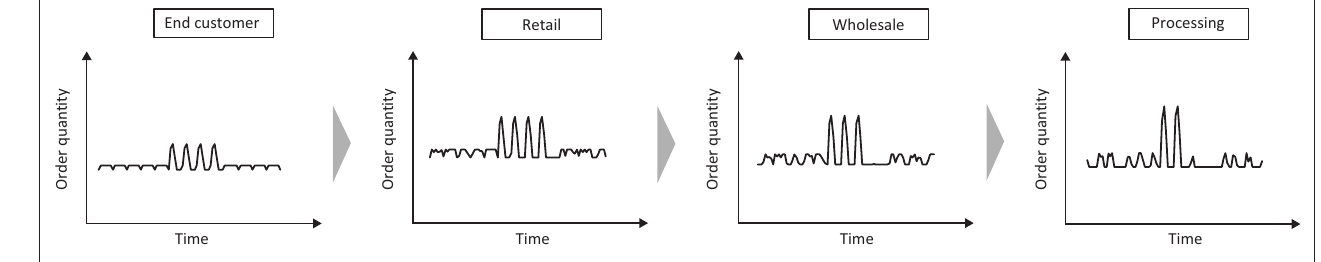
FIGURE 2: The bullwhip effect: Extract of the amplification of order quantities upstream the supply